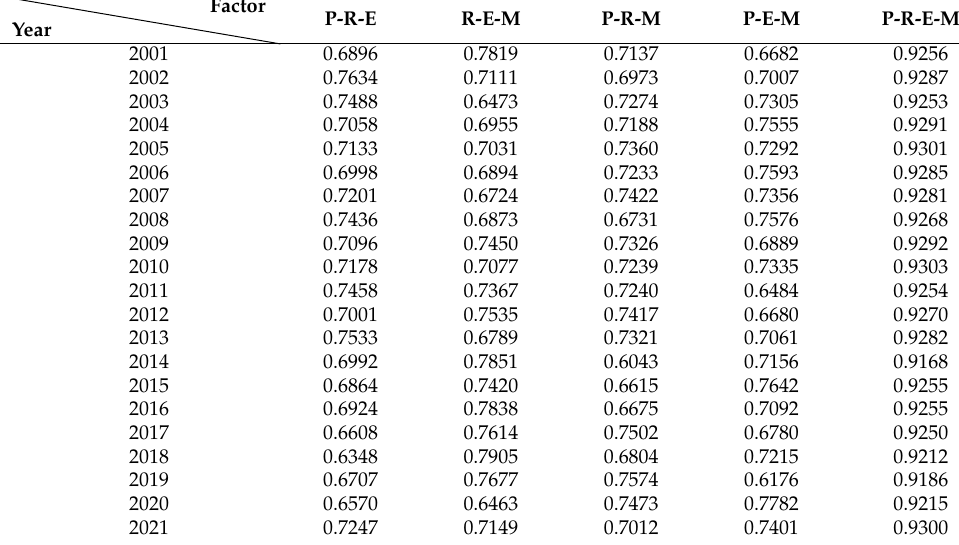
Table 5. The coupling degree B j of three risk factors and four risk factors.